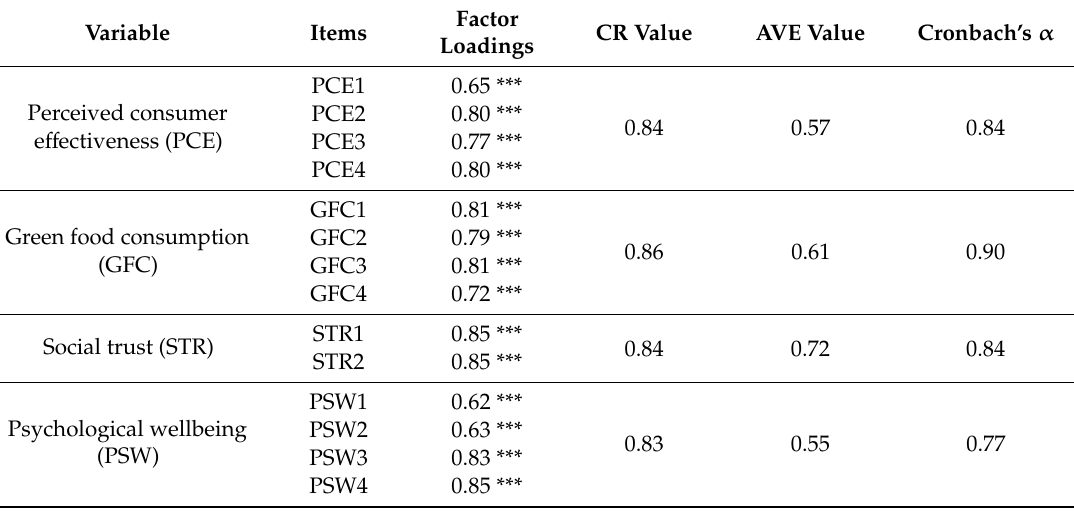
Table 4. Results of the measurement model ( N =